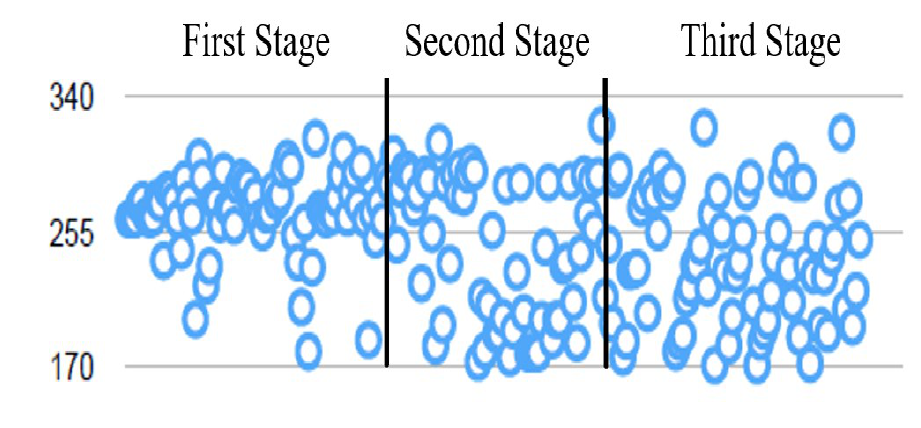
Figure 2. The specific impulse of different stages taken from the database ©Mark Wade [18].